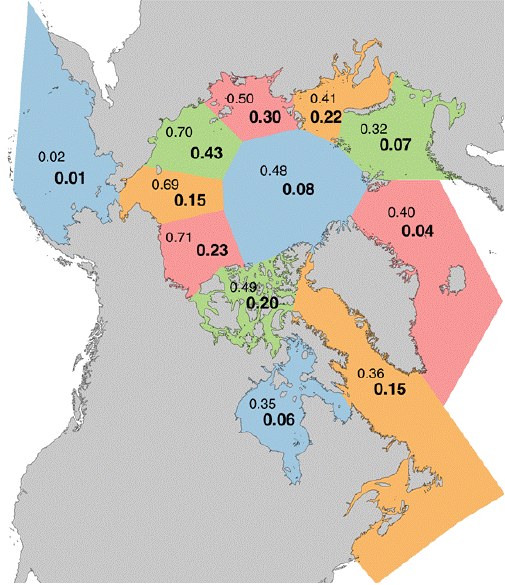
Figure 7. Squares of correlations ( R 2 ) between September pan- Arctic ice extent and September regional ice extent based on ice ex- tents including trends (upper numbers in normal font) and detrended (lower numbers, bold font). The 95% significance thresholds for the correlations range from 0.26 with no autocorrelation (generally the case for detrended data) to 0.38 with an autocorrelation of 0.4; the corresponding R 2 thresholds are 0.07 and